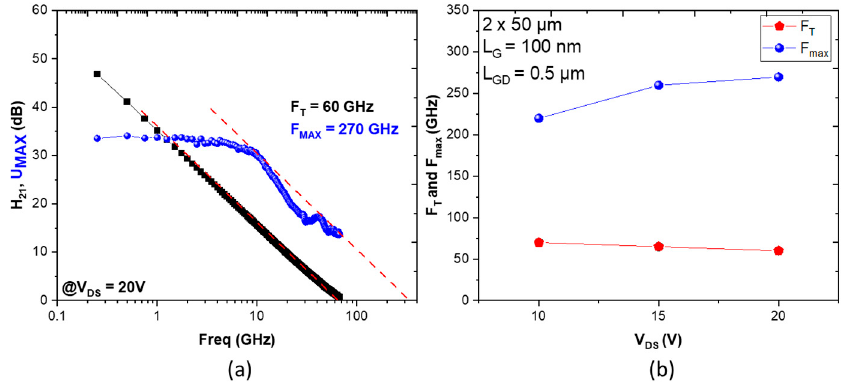
Figure 4. ( a ) F T /F max at V DS = 20 V and ( b ) F T /F max as a function of V DS for a 2 × 50 µm AlN/GaN HEMT (Al-25%) with L G = 100 nm and L GD = 0.5 µm.